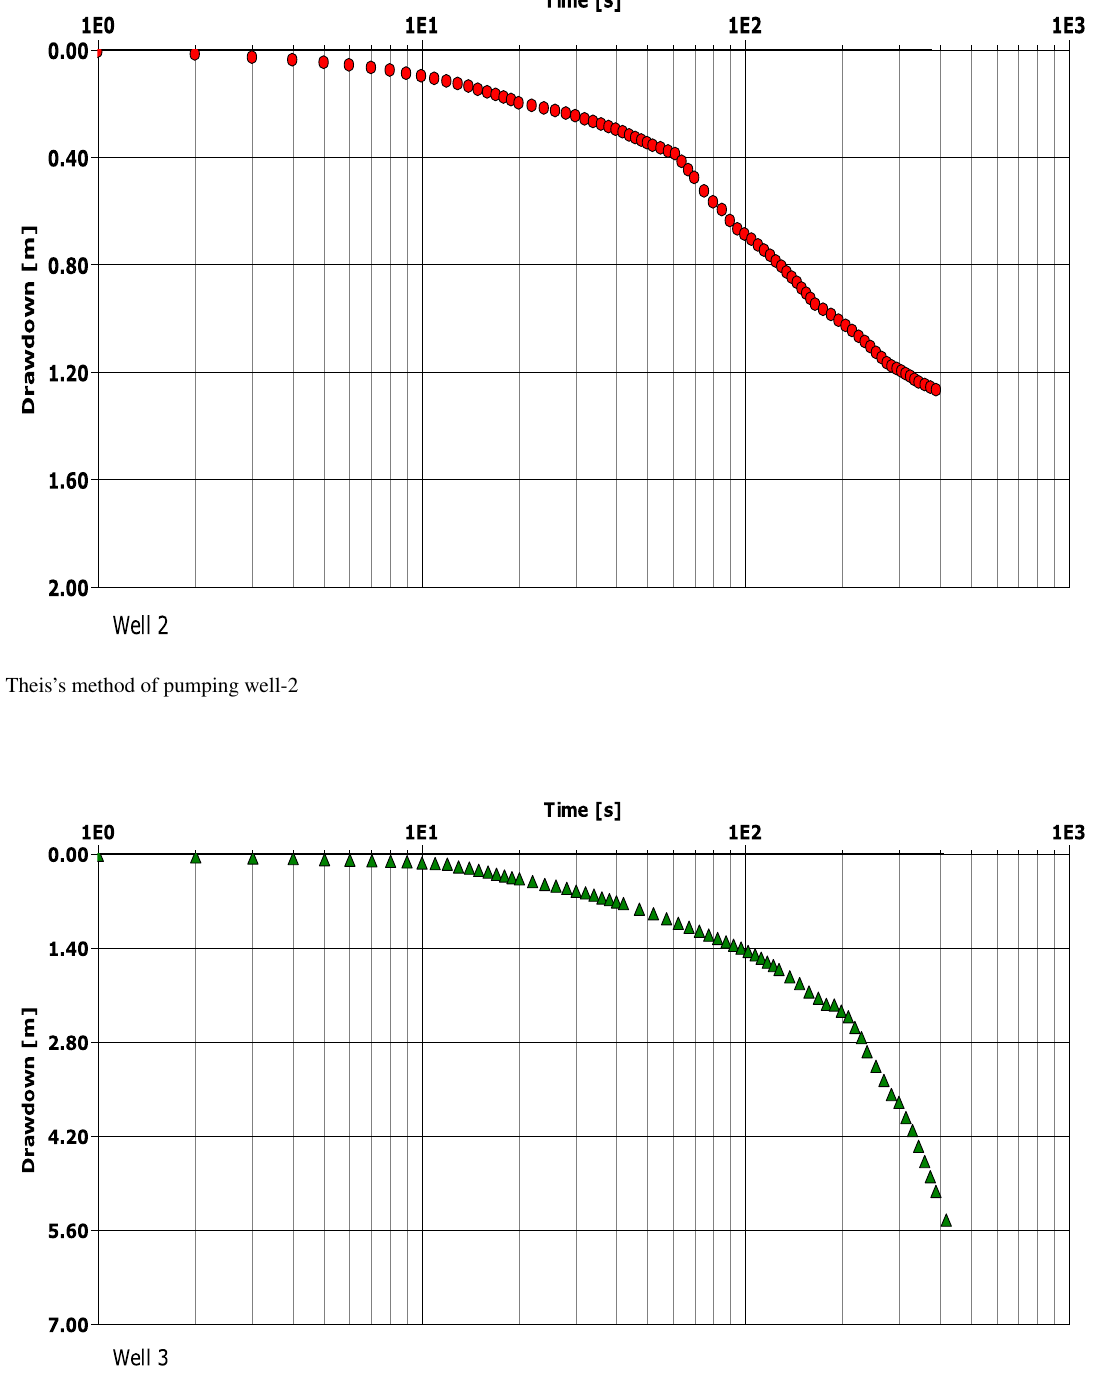
Fig. 20 Theis’s method of pumping